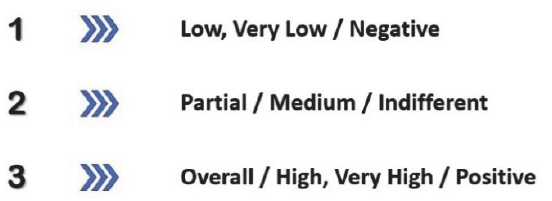
Figure 5. Scale used for measuring indicators. Source: own elaboration.